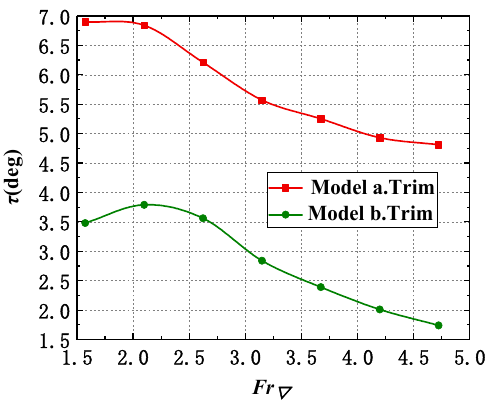
Figure 13. Comparisons of the numerical results of Model a and Model b for volume Froude numbers ranging from 1.57 to